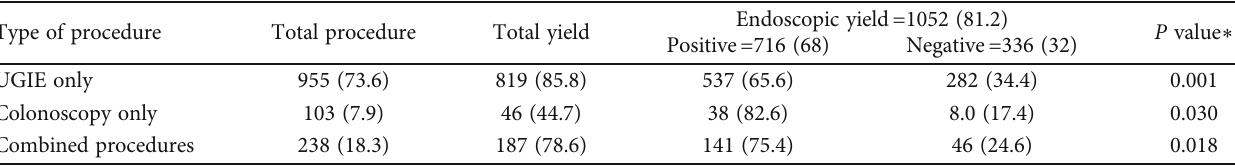
Table 3: Endoscopic yield in children underwent gastrointestinal endoscopic sessions ( n = 1,296